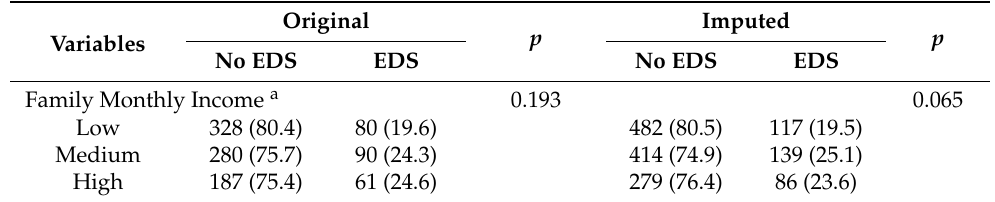
Table A2. Sensitivity analysis of the association between characteristics and EDS of the adolescents (n%).